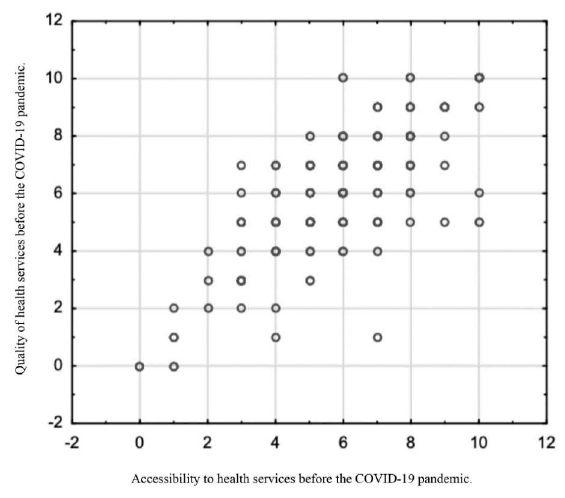
Figure 7. Correlation between accessibility and quality – assessment before the COVID-19 pandemic